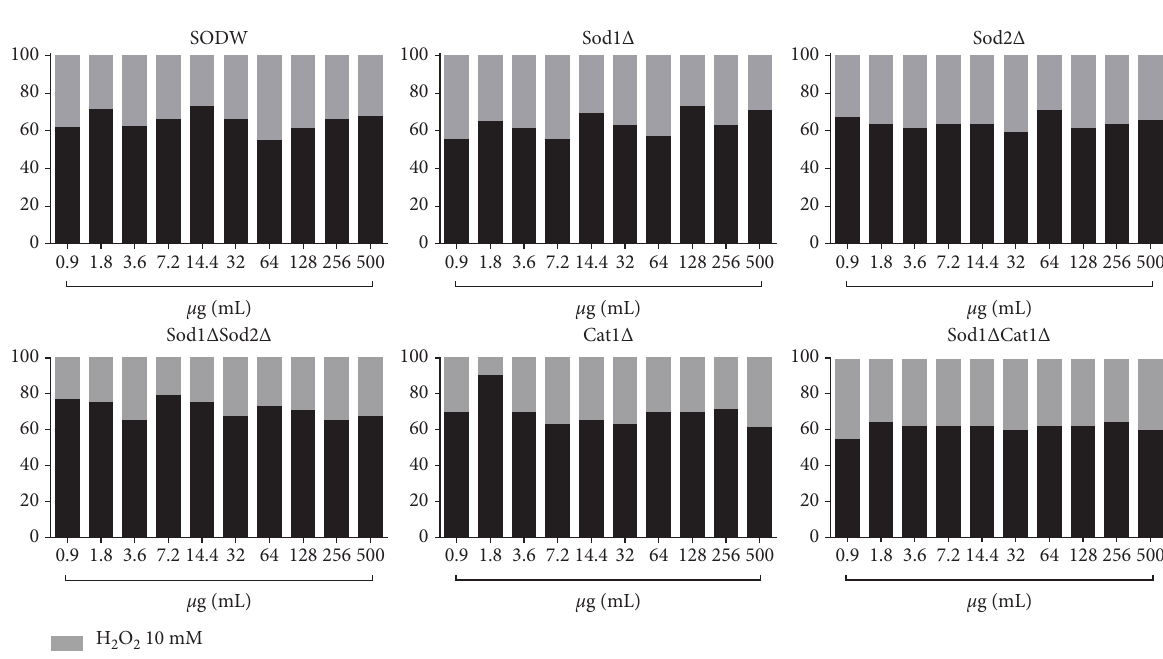
Figure 7: Modulatory efect of estragole in oxidative damage induced by hydrogen